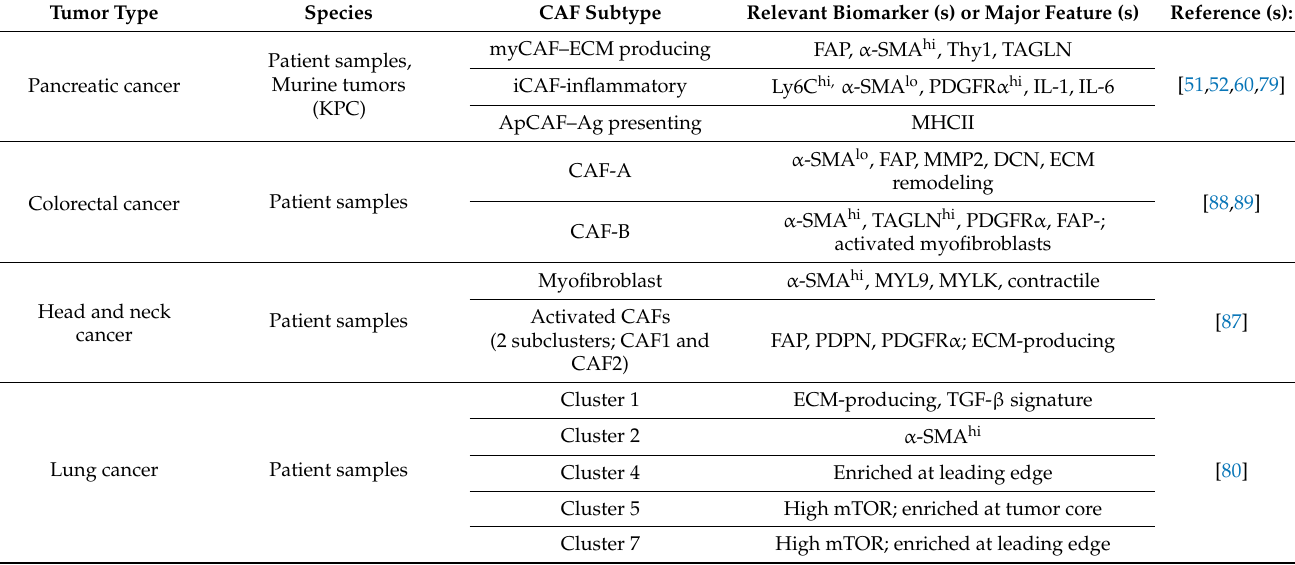
Table 2. Cancer-associated fibroblast subtypes across different